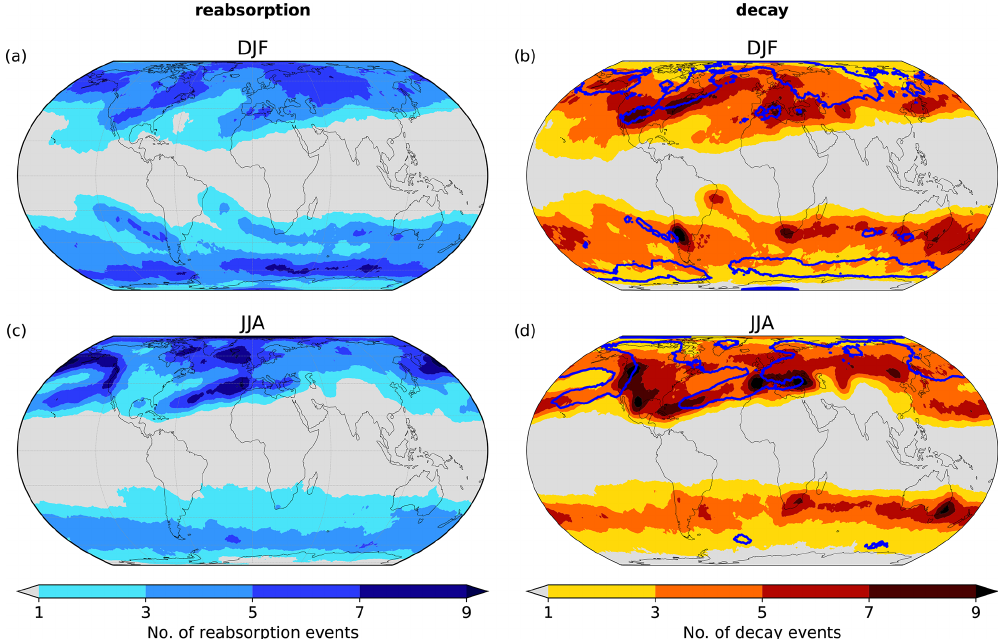
Figure 7. Average number of (a, c) reabsorption (less than 50% decay, blue shading) and (b, d) diabatic decay (more than 50% decay, red shading) events per season within a distance of 500km for (a, b) DJF and (c, d) JJA. As a reference, the contour for five reabsorption events per season (blue contour) is shown (b, d)